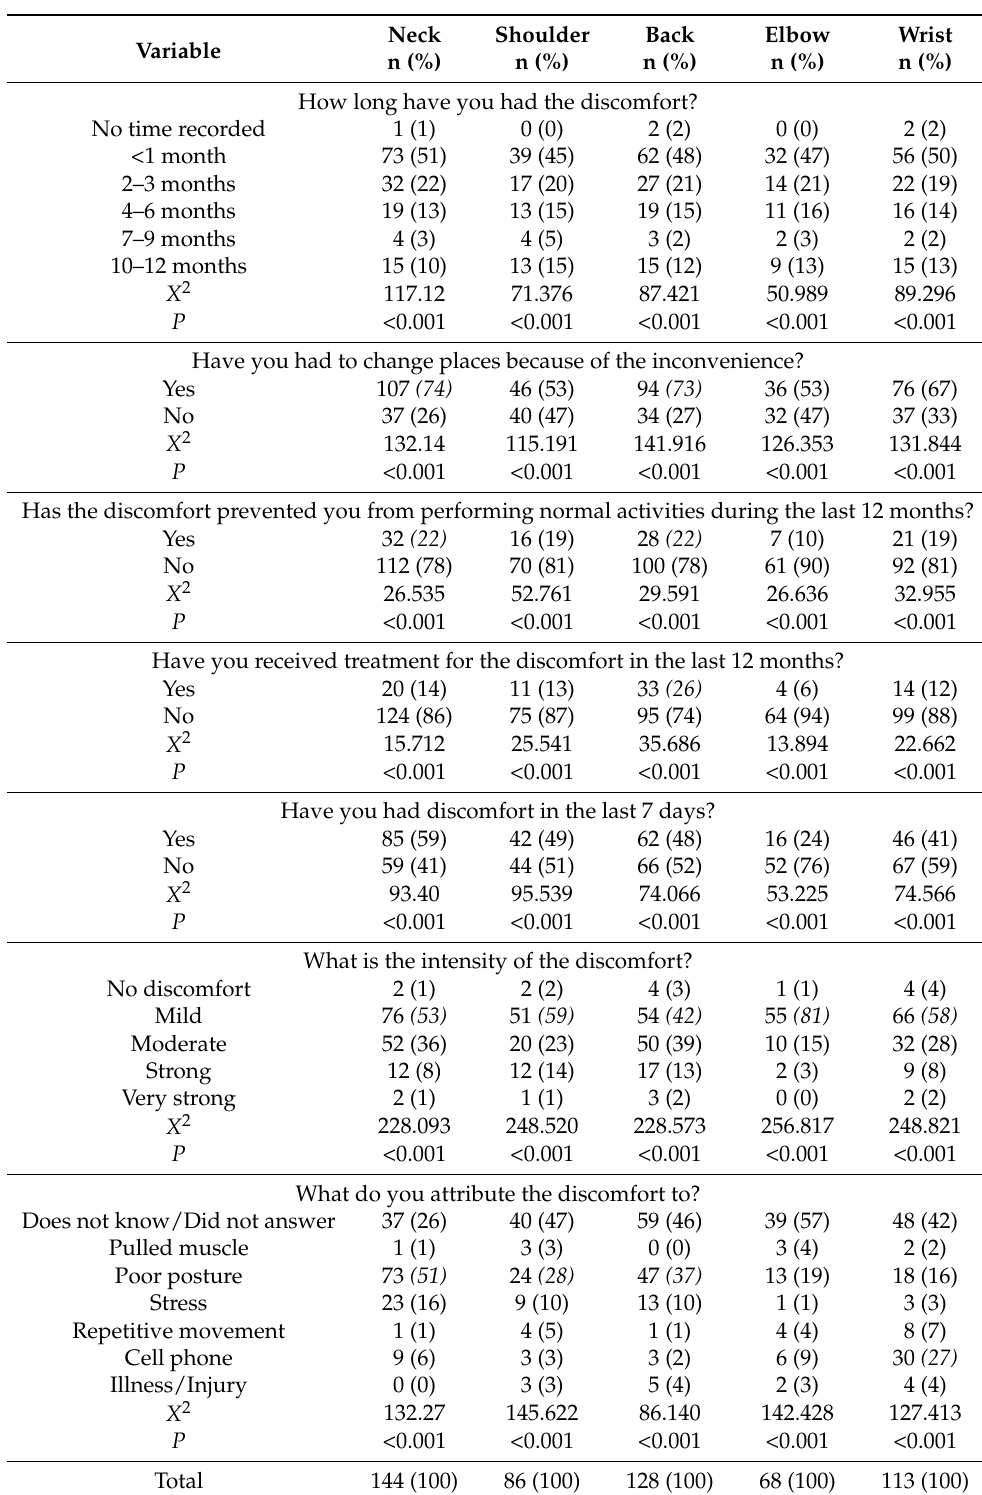
Table 2. MSSs’ Characteristics According to the Nordic